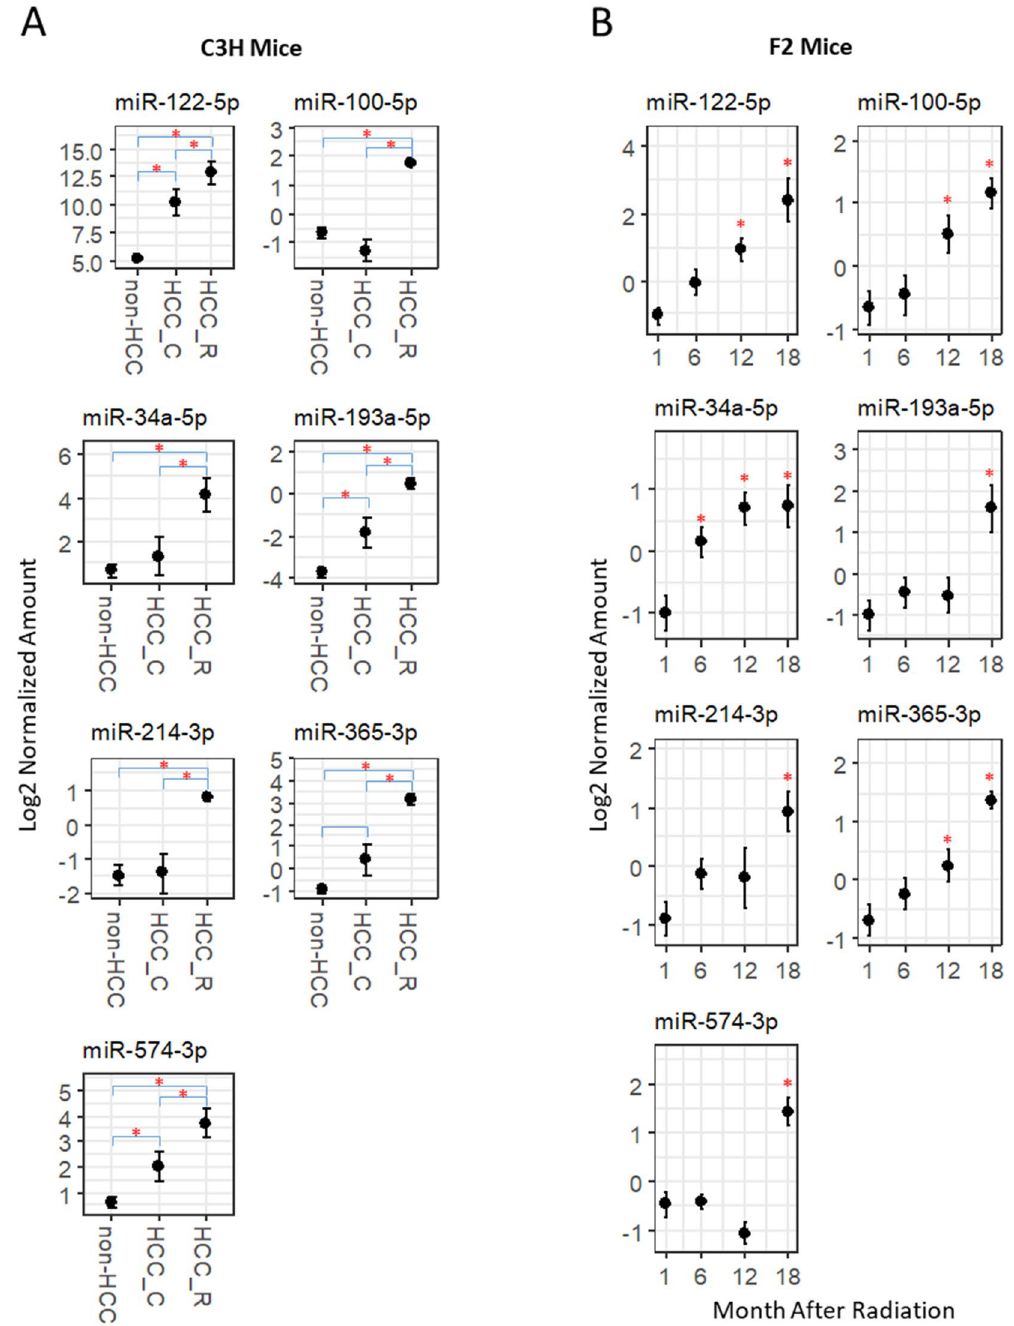
Figure 4. Human HCC-associated circulating miRNAs overlapped with mouse hub miRNAs in two strains of mice. ( A ) Mouse orthologs of human HCC circulating miRNA markers in the plasma C3H mice with HCC diagnosis. HCC_R radiation-induced HCC, HCC_C spontaneous HCC. Red star: significantly different between groups (p < 0.05). Error bar: standard error. ( B ) Mouse orthologs of human HCC circulating miRNA markers in the plasma of F2 mice with HCC diagnosis. Red star: significantly different from 1-month group (p < 0.05). Error bar: standard